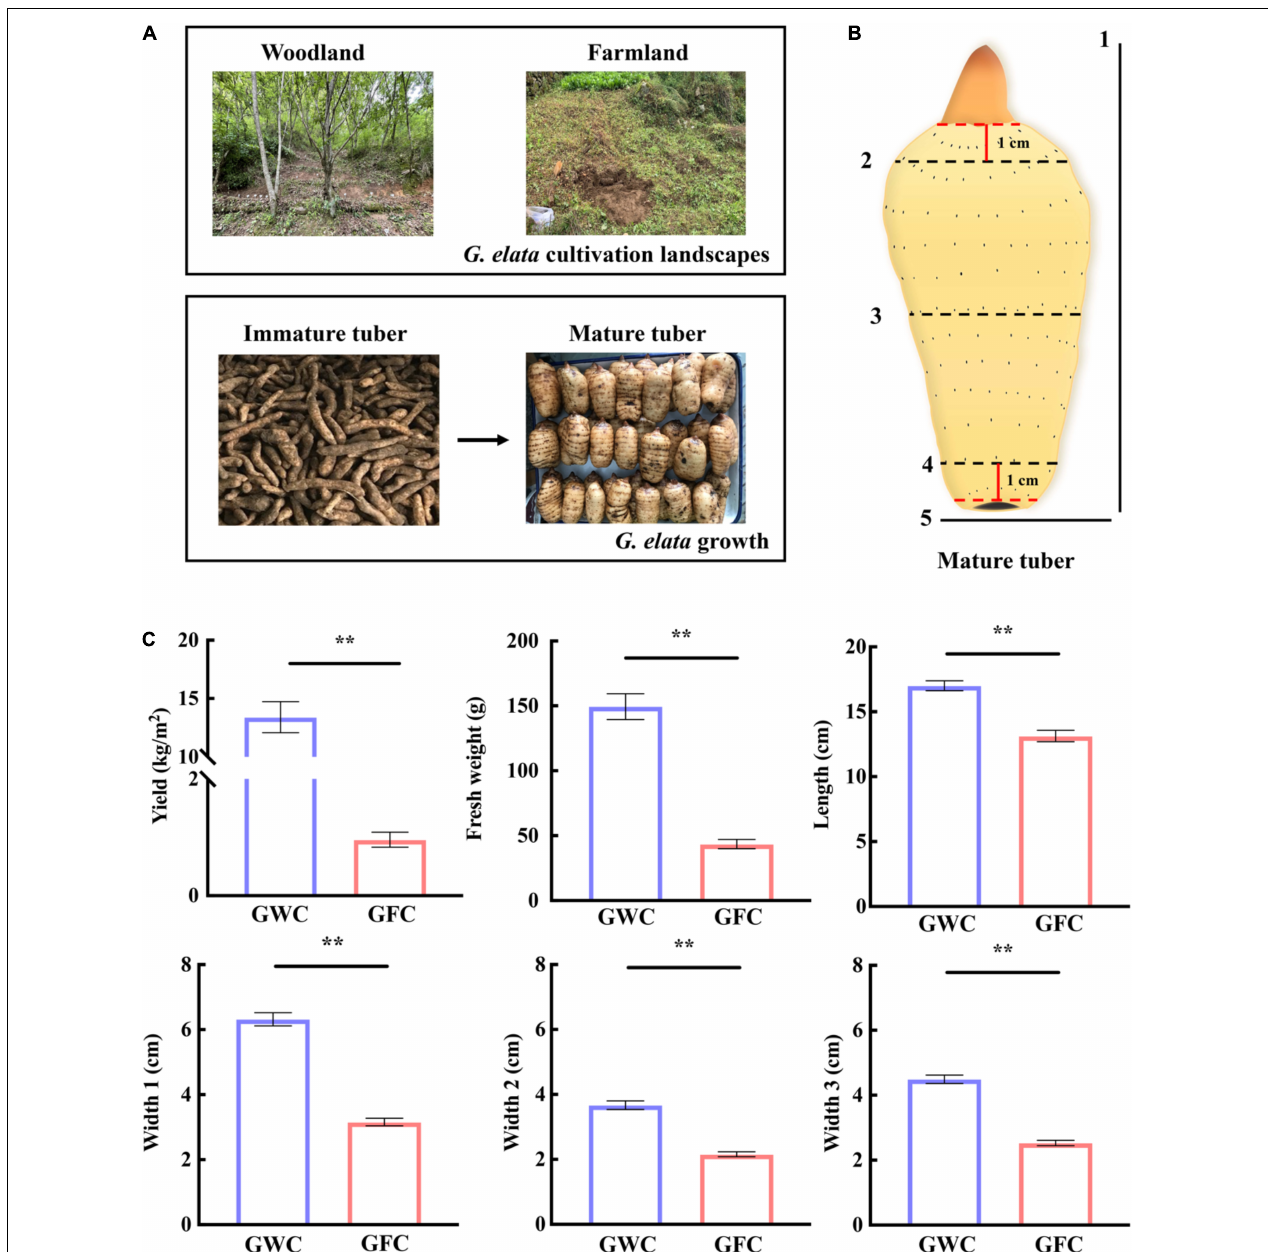
FIGURE 1 | G. elata cultivation, growth, and evaluation of mature tuber agronomic traits. (A) Cultivation of G. elata in woodland or farmland. (B) Agronomic traits of G. elata mature tubers. 1, length; 2, width at 1 cm from top bud (Width 2); 3, half of tuber width (Width 1); 4, width at 1 cm from tuber bottom (Width 3); 5, weight. (C) Yield, tuber weight, and agronomic trait evaluation of G. elata . GWC, G. elata cultivated in woodland; GFC, G. elata cultivated in farmland. Data are shown as means ± SE. ** P <